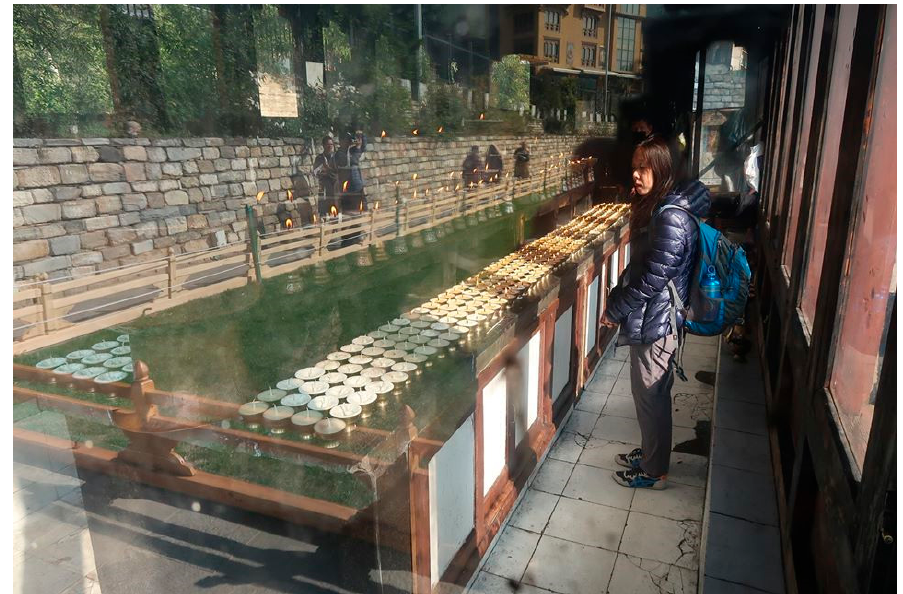
Figure 3. Shin Yu Pai inside a hall of flaming butter lamps at the Gangteng Monastery in the Phobjika Valley, Bhutan. Image courtesy of Jim Brewer.